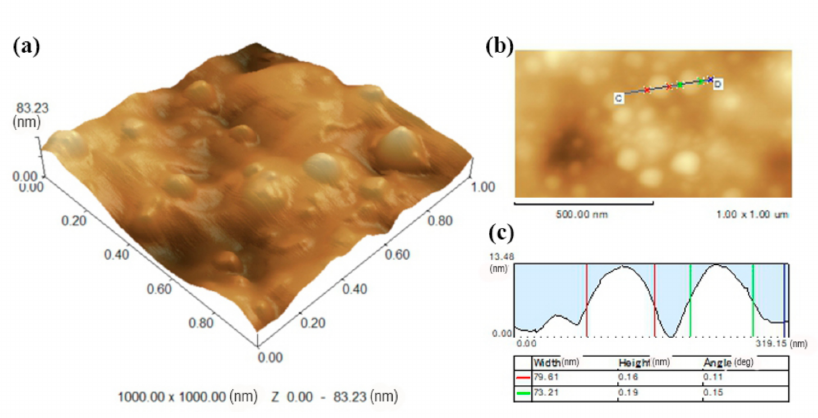
Figure 4. AFM imaging of 1 wt% nano-copper-modified PF resin. ( a ) and ( b ) are the three- dimensional and two-dimensional image of AFM, respectively; ( c ) the section analysis image of